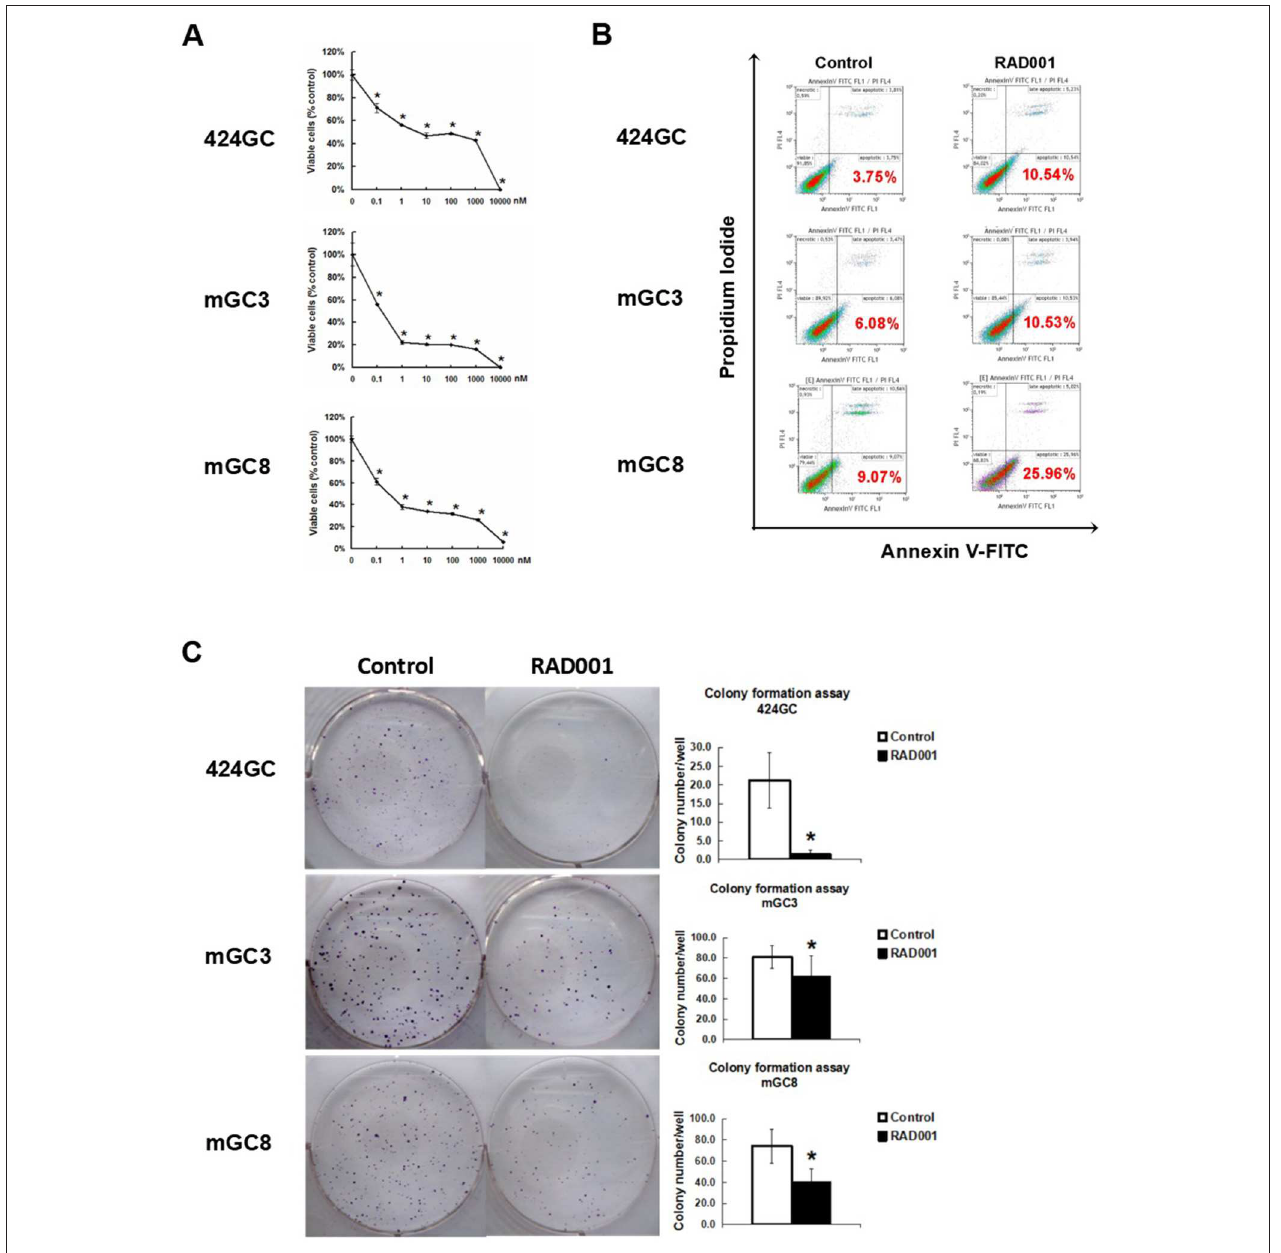
FIGURE 2 | mTOR inhibitor RAD001 induced anti-tumor effects in vitro . (A) RAD001 efficiently inhibited cell proliferation in a dose dependent manner. WST-1 absorption was tested after 72h treatment. The experiments were performed in triplicate. * p < 0.05 vs. control. (B) Cells treated with 100nM RAD001 for 72h were tested for apoptotic rate. Higher apoptotic rates were observed in the cell samples treated with RAD001. (C) Cells treated with 100nM RAD001 for 72h were seeded into 6-well plate for colony formation. Decreased clone numbers were observed in the treated group ( n = 6 for each group, * p < 0.05: RAD001 treated group vs. control